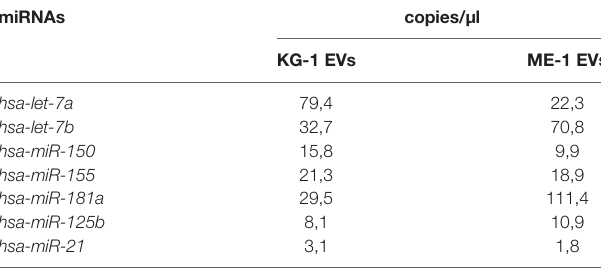
TABLE 1 | AML-EV miRNA quanti fi cation in KG-1 EVs and ME-1 EVs. miRNAs